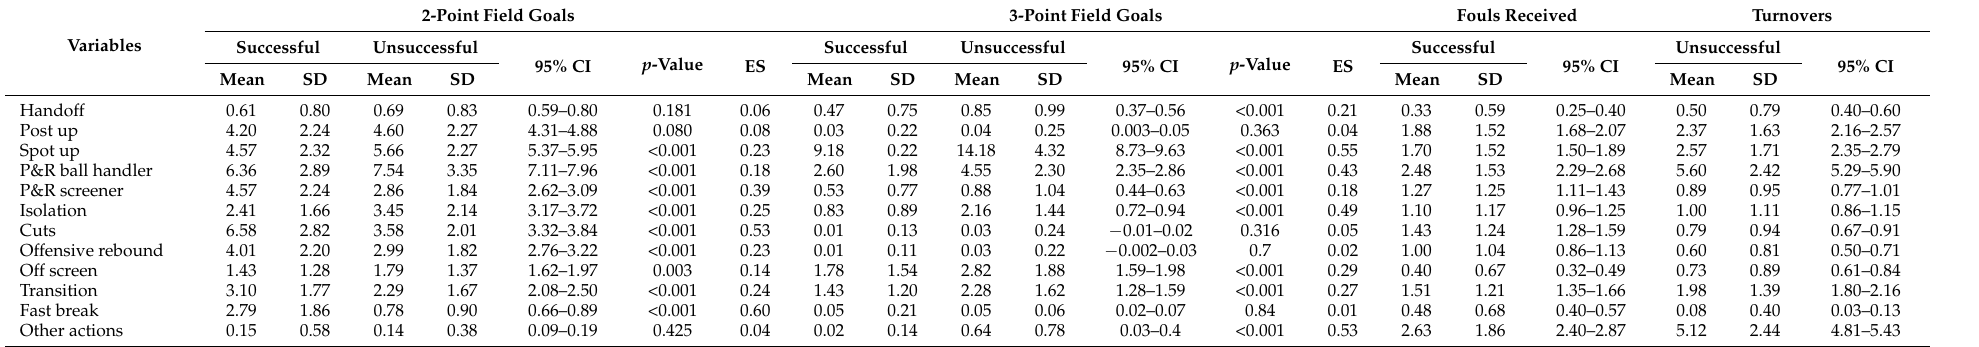
Table 2. Description of the ends of the ball possession during the